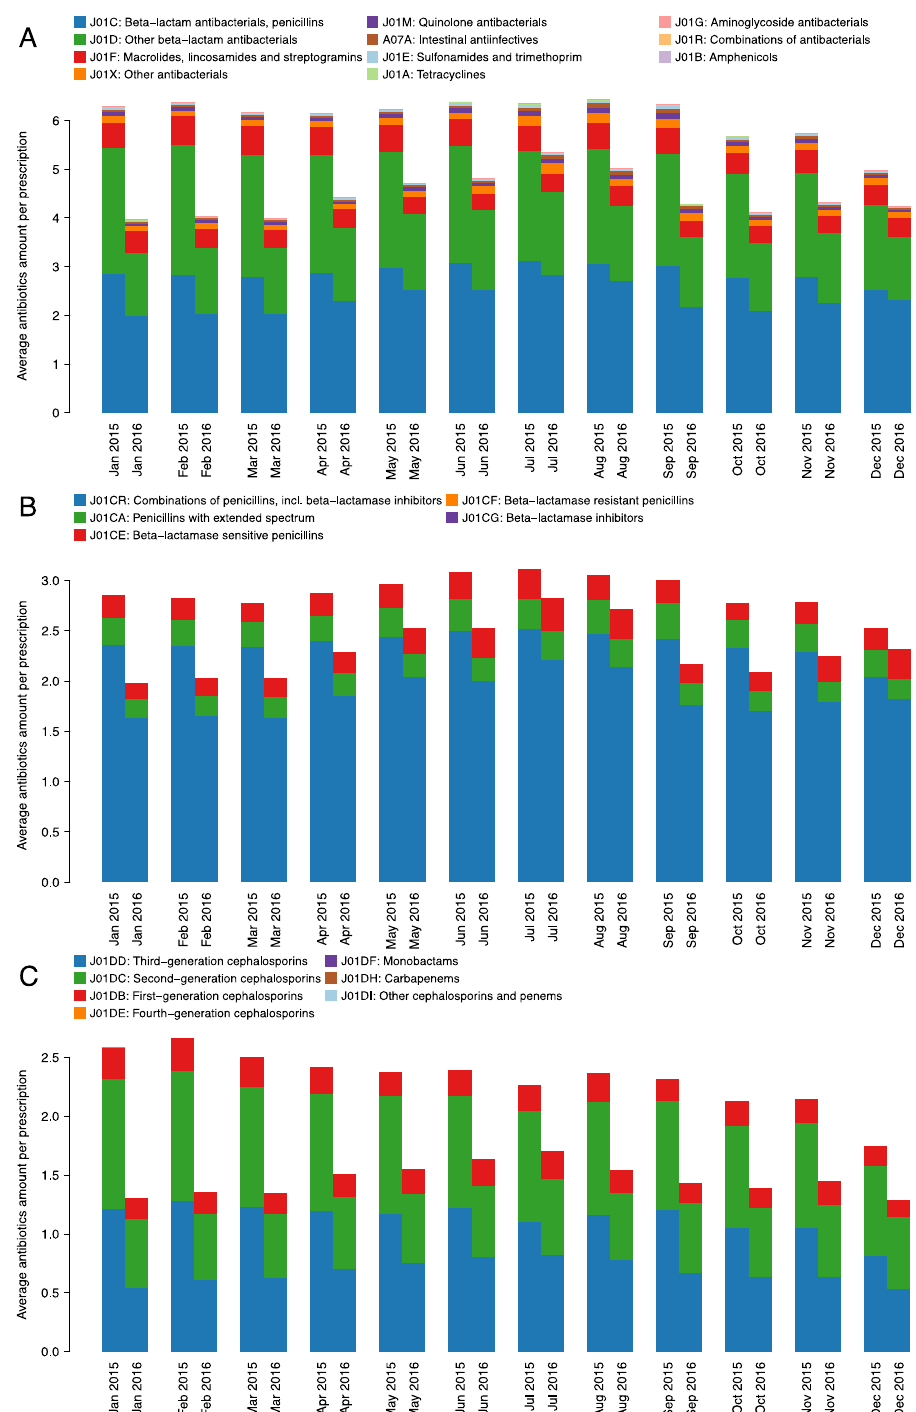
Figure 3. Monthly average antibiotics amounts per prescription for Denizli, where the highest decrease was observed, among the diagnosis of “acute upper respiratory infections” in 2015 and 2016. ( A ) Breakdown with respect to third level ATC codes, ( B ) Breakdown with respect to “beta-lactam antibacterials, penicillins” (i.e., ATC code J01C), and ( C ) Breakdown with respect to “other beta-lactam antibacterials” (i.e., ATC code